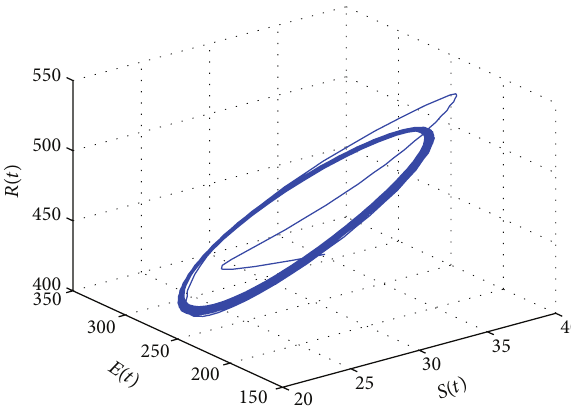
Figure 4: The phase plot of the states 𝑆 , 𝐸 , and 𝑅 for 𝜏 1 = 20.0500 > 17.2530 = 𝜏 10 .